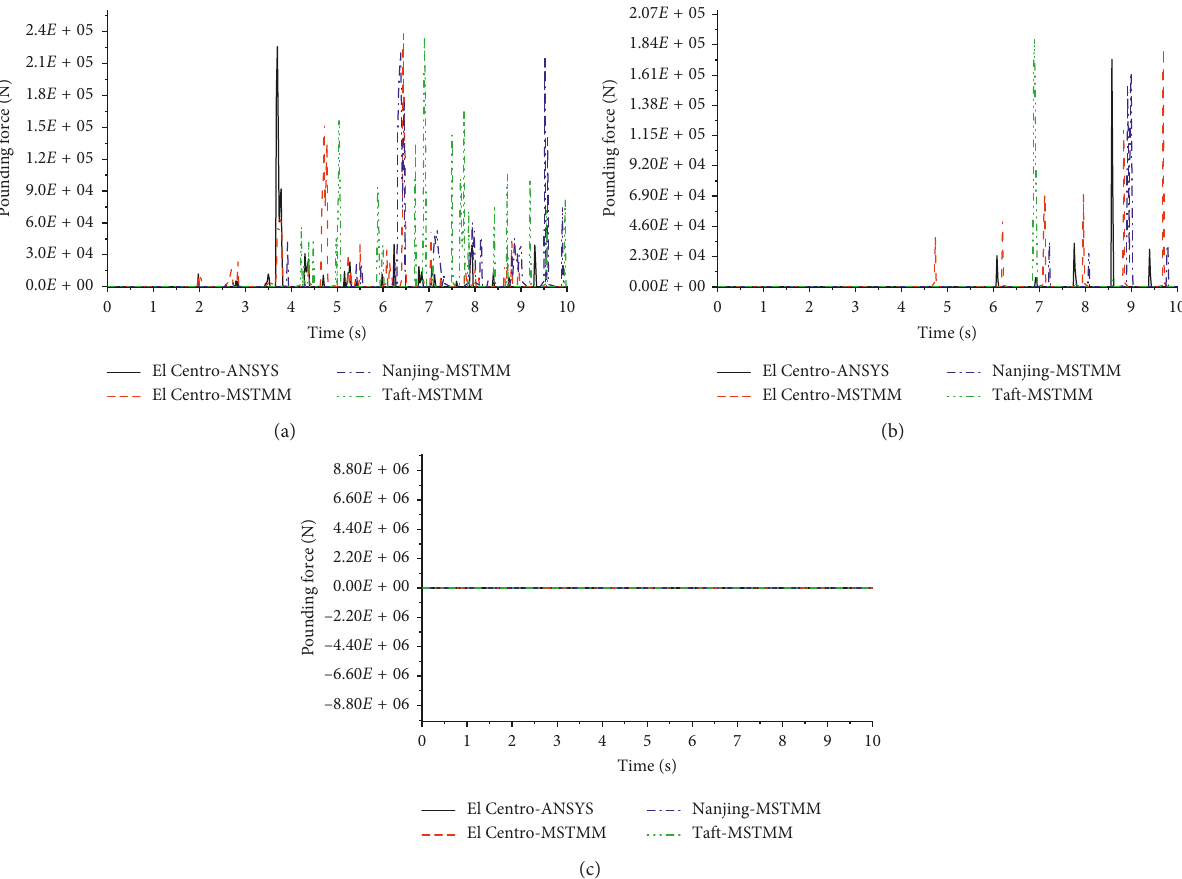
a -J 1 , a pounding force under seismic wave (peak acceleration is 70cm/s 2 ). (a) 10mm, (b) 40mm, 2 , 35 15